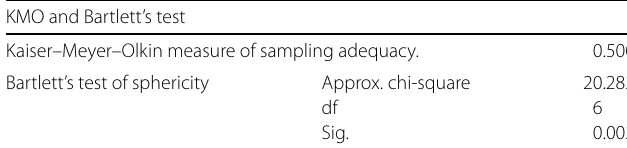
Table 6 The result of the Kaiser–Meyer–Olkin (KMO) measure of sampling adequacy KMO and Bartlett’s